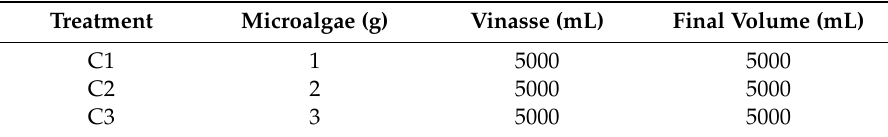
Table 3. Inoculation of concentrated C. vulgaris in